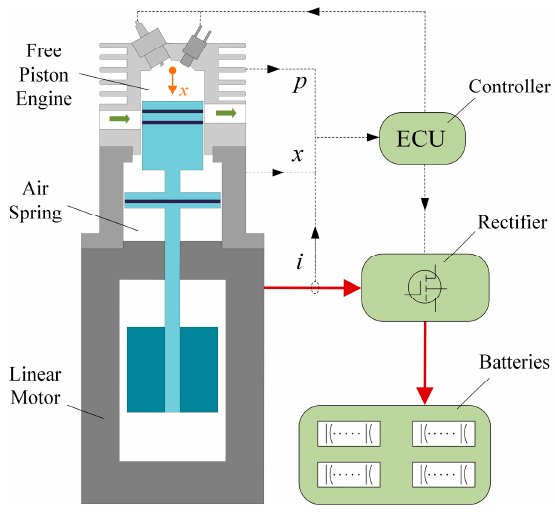
Figure 1. Free-piston engine generator sketch.